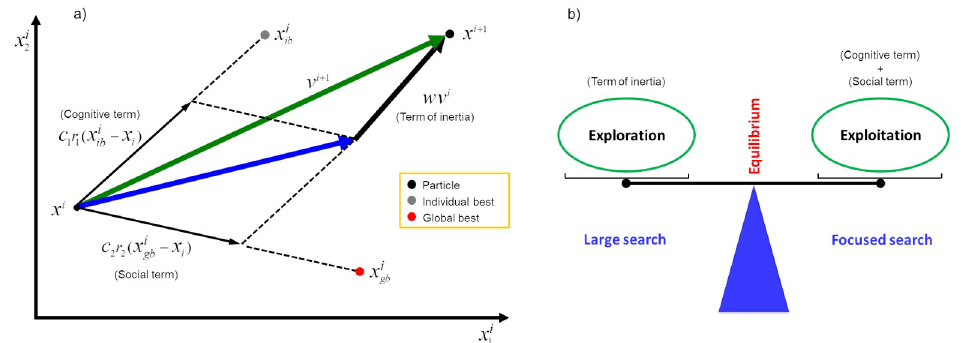
Fig 3. Exploration versus exploitation. (a) The three vectors associated with updating the velocity of particle in the original PSO—inertia, cognitive and social learning terms and (b) Balancing between exploration and exploitation